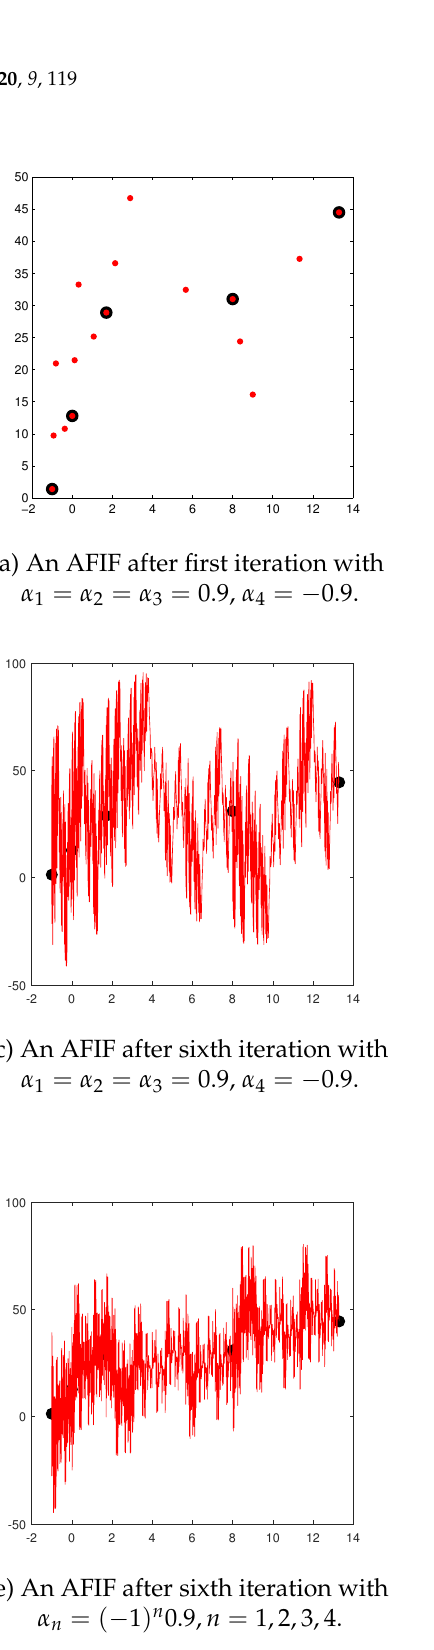
Figure 1. Affine